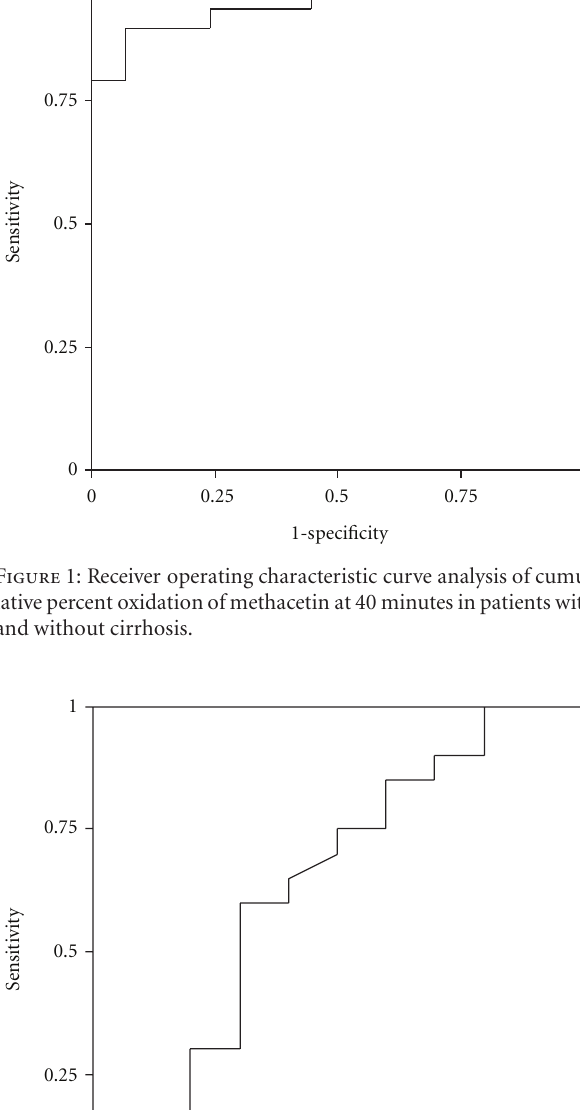
0.80 ± 0.25, P = . 33). Similar results were obtained for cumulative recovery percentages at 120 minutes (Table 2).